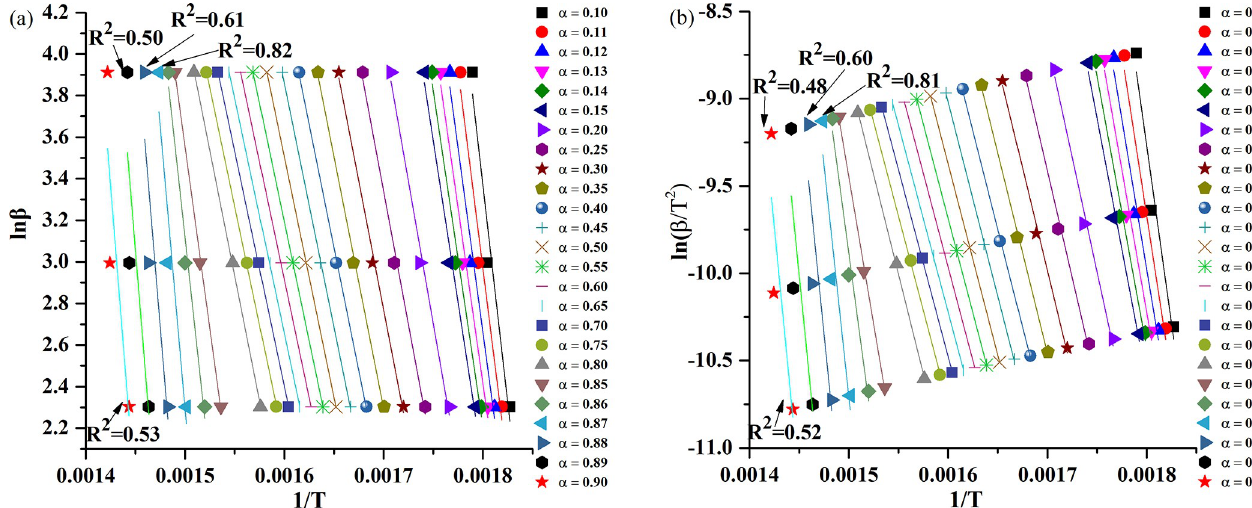
Fig 5. The linear fitting diagrams of IMPG-HT samples. (a) The linear fitting diagrams of IMPG-HT samples obtained by FWO method within the conversion range of 0.10 < α < 0.90; (b) The linear fitting diagrams of IMPG-HT samples obtained by KAS method within the conversion range of 0.10 < α <